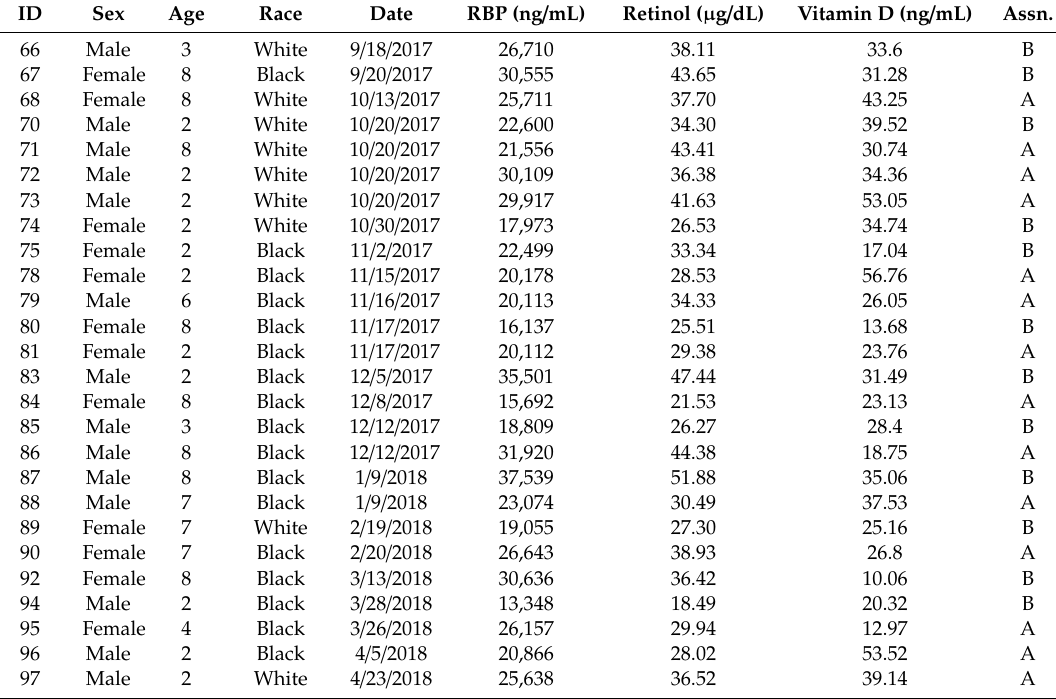
Table A3. Patient Characteristics